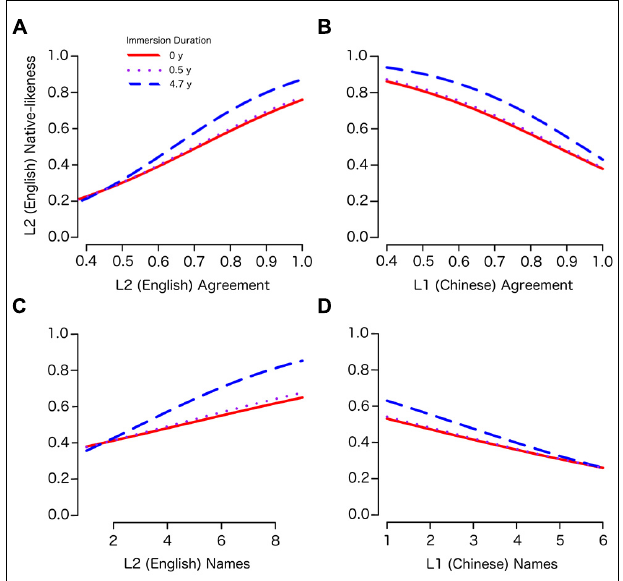
FIGURE 4 |Two-way interaction plots for Immersion and each of the linguistic community norm variables. (A) L2 native speaker